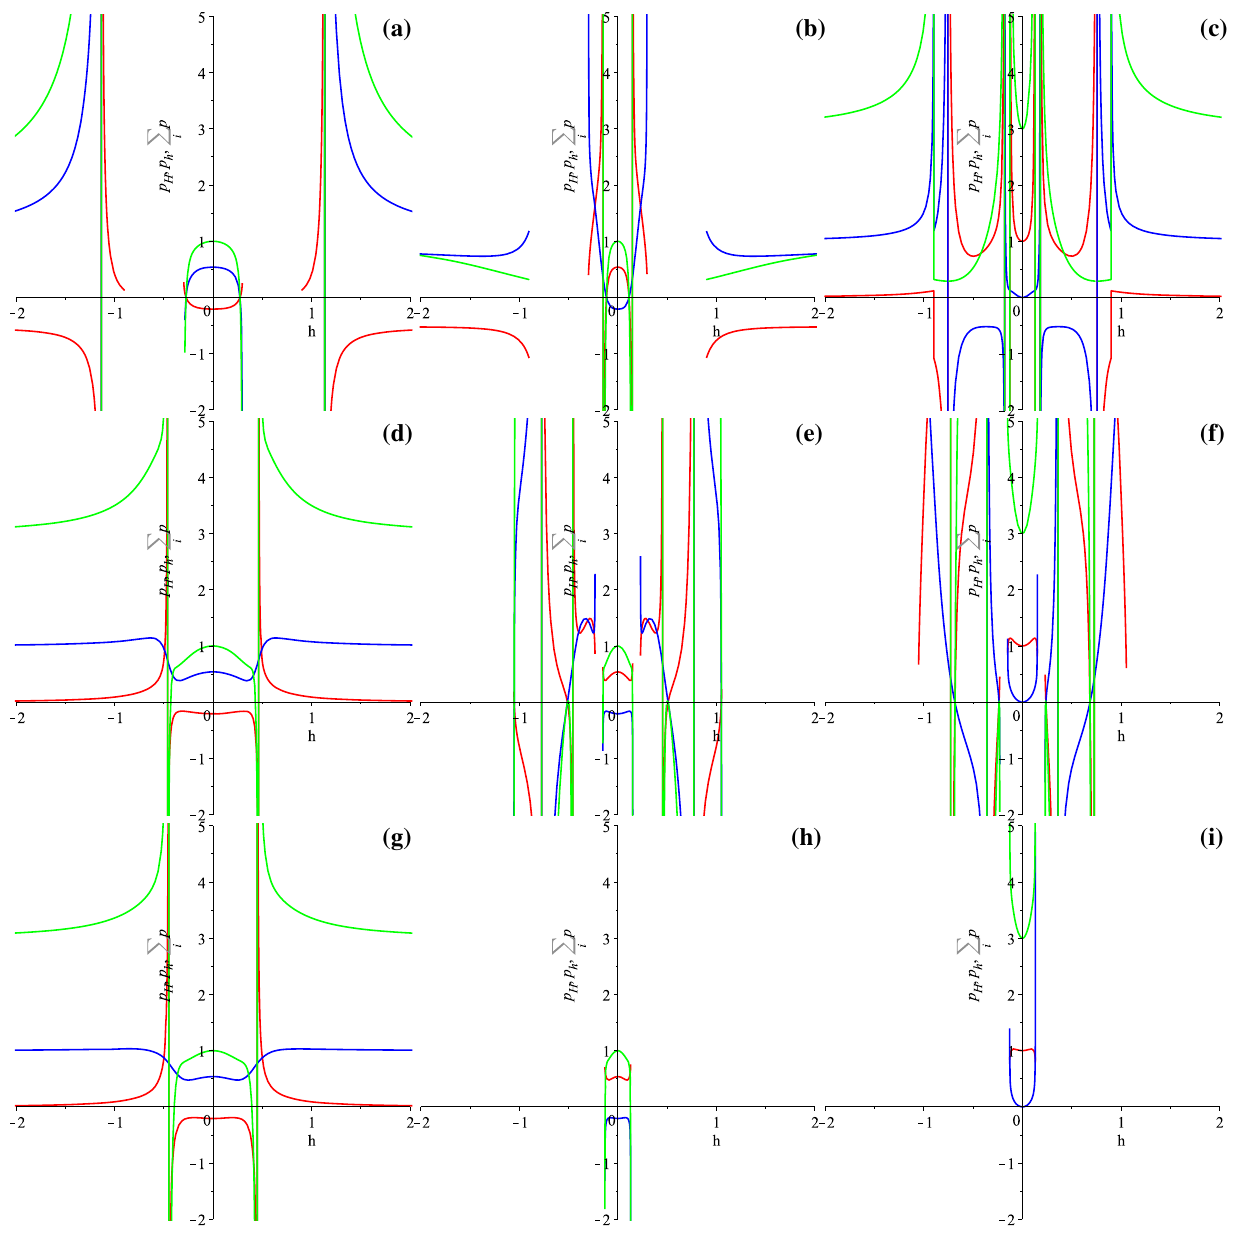
(cid:14) Fig. 5 p H , p h and p i graphs for vacuum D = 3 case: p H in red, (cid:14) p h in blue and p i in green; α > 0, β < 0 on a – c panels: H 1 branch on a panel, H 2 branch on b panel and H 3 branch on c panel; α > 0, β > 0, μ < 0 . 3 on d – f panels: H 1 branch on d panel, H 2 branch on e